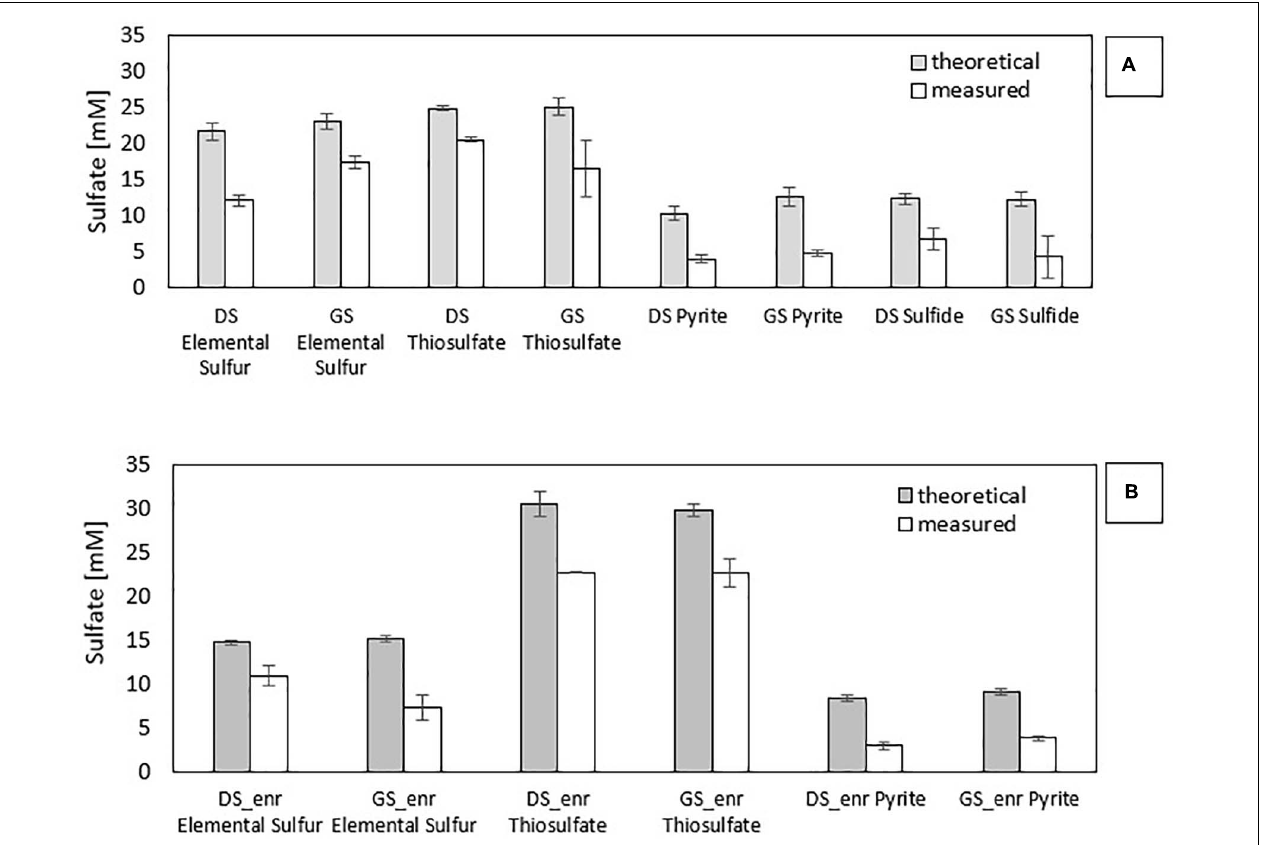
Figure 2 | Comparison of measured and theoretical sulfate concentrations for all enrichments: (A) first incubation with the inocula and (B) last transfer with the enrichments.